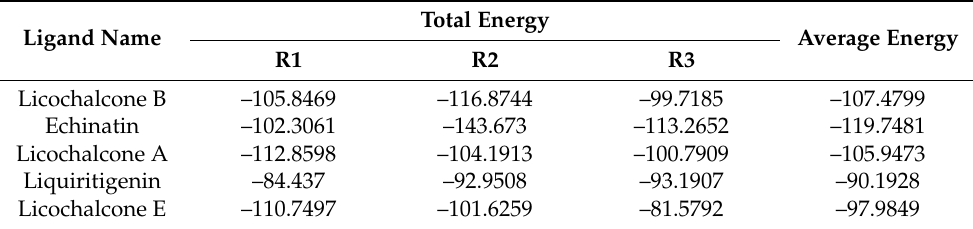
Table 3. The MD simulation interaction energy of the top five compounds was predicted in the